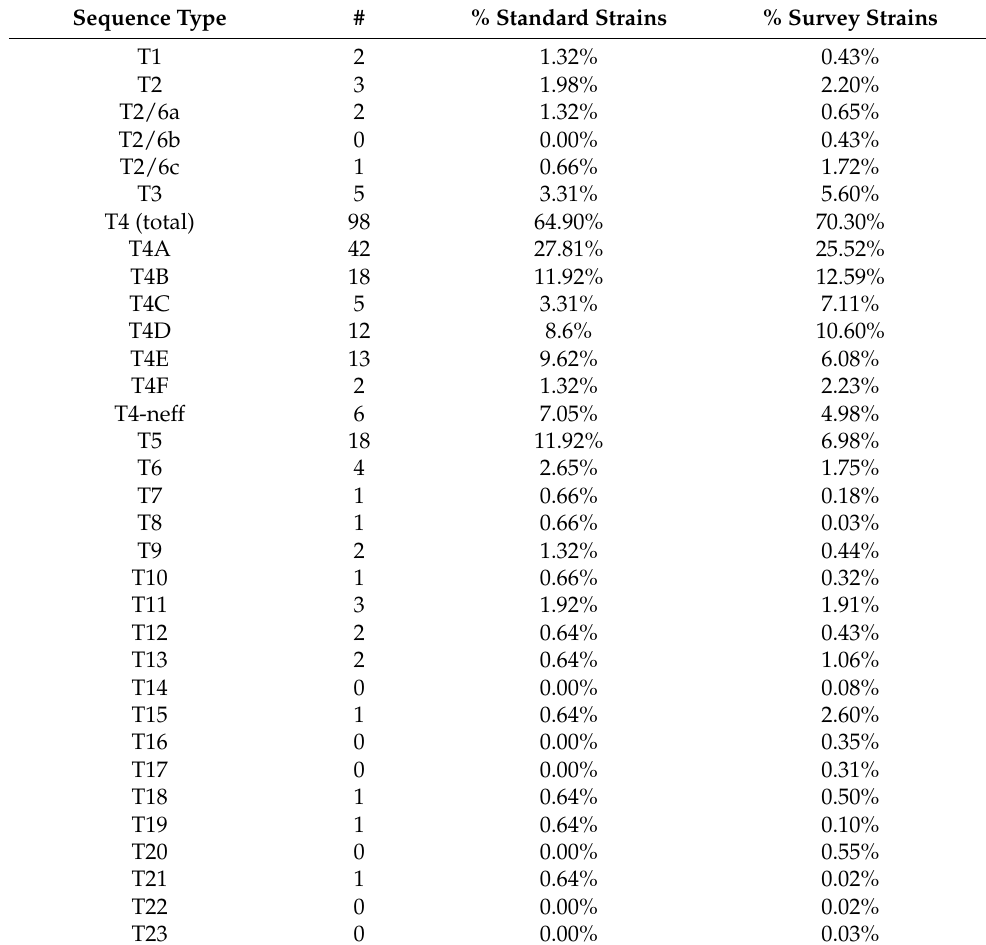
Table 3. Frequency of Sequence Types for standard strains with genotype data and percentage of Sequence Types in all isolates from clinical or environmental